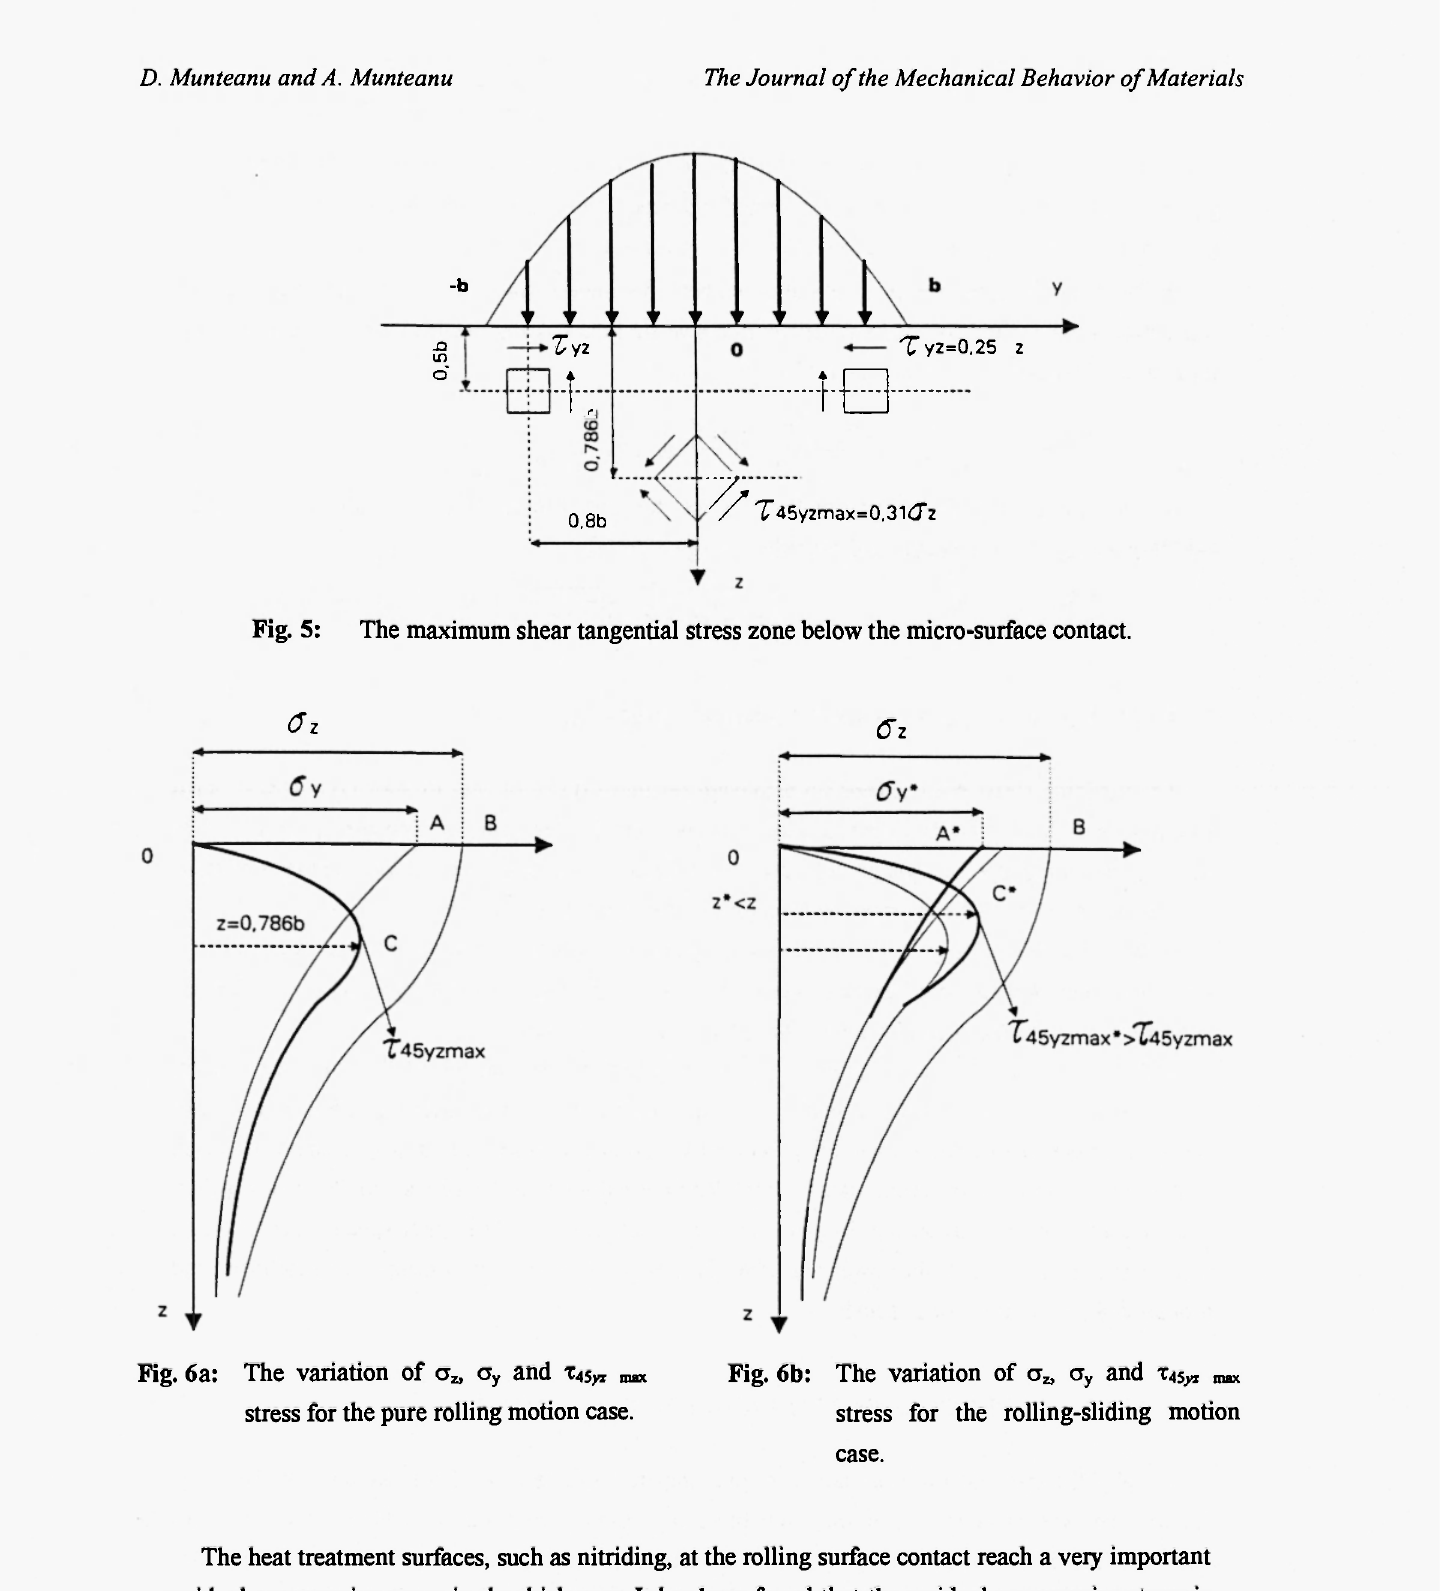
Fig. 6a: The variation of σ stress for the pure rolling motion case.